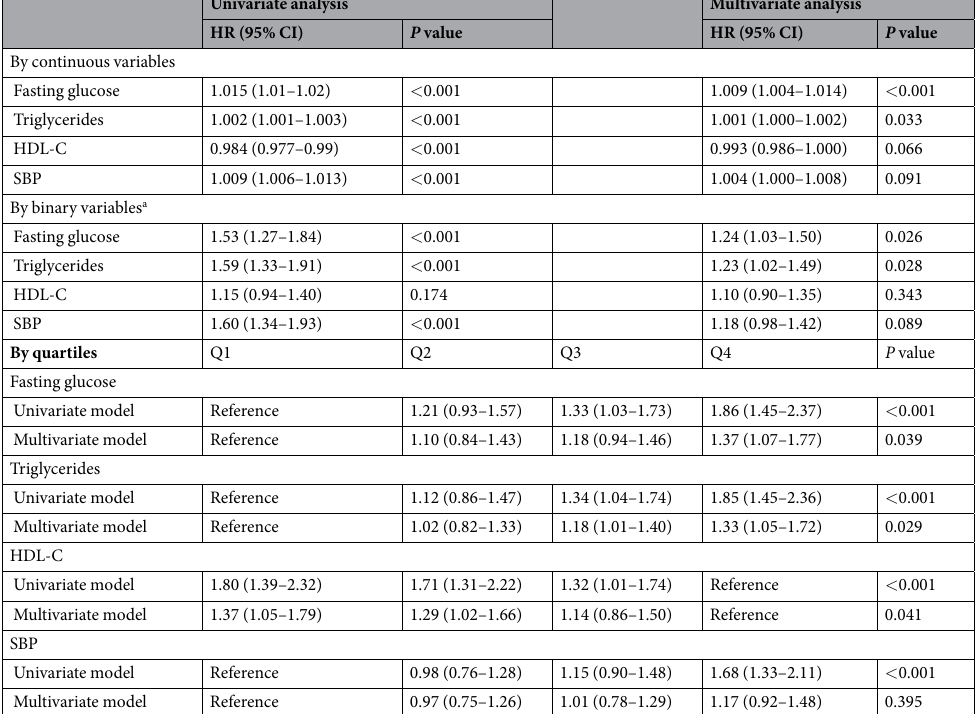
Table 5. The association between the metabolic parameters and metachronous advanced colorectal neoplasia. Cox proportional hazard models adjusted for age, sex, body mass index, smoking status, alcohol intake, regular exercise, regular aspirin use, family history of colorectal cancer, and high risk adenoma at screening colonoscopy. a Binary cutoff points: (1) high serum triglycerides ≥ 150 mg/dL; (2) low high-density lipoprotein- cholesterol ≤ 40 mg/dL for men and ≤ 50 mg/dL for women; (3) high systolic blood pressure ≥ 130 mmHg; (4) high fasting glucose > 100 mg/dL HR, hazard ratio; CI, confidence interval; HDL-C, high-density lipoprotein cholesterol; SBP, systolic blood